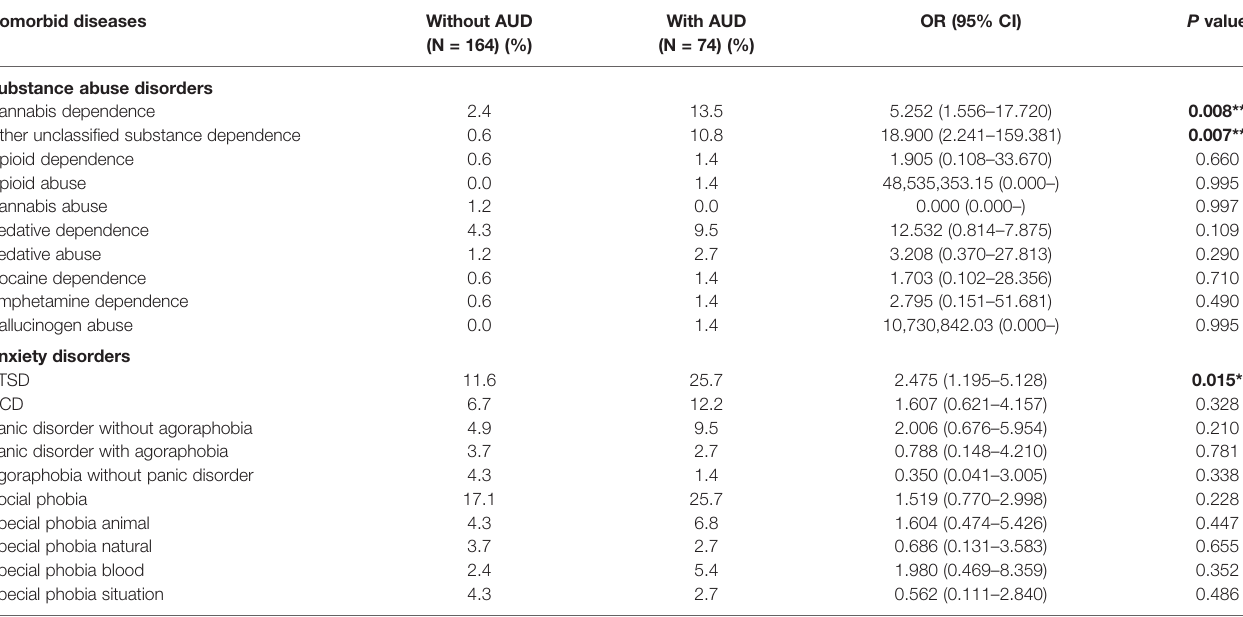
TABLE 2 | Logistic regression analysis of potential risk factors in comorbidities with substance abuse disorders and anxiety disorders of bipolar patients after adjusting for age and gender. Comorbid diseases Without AUD